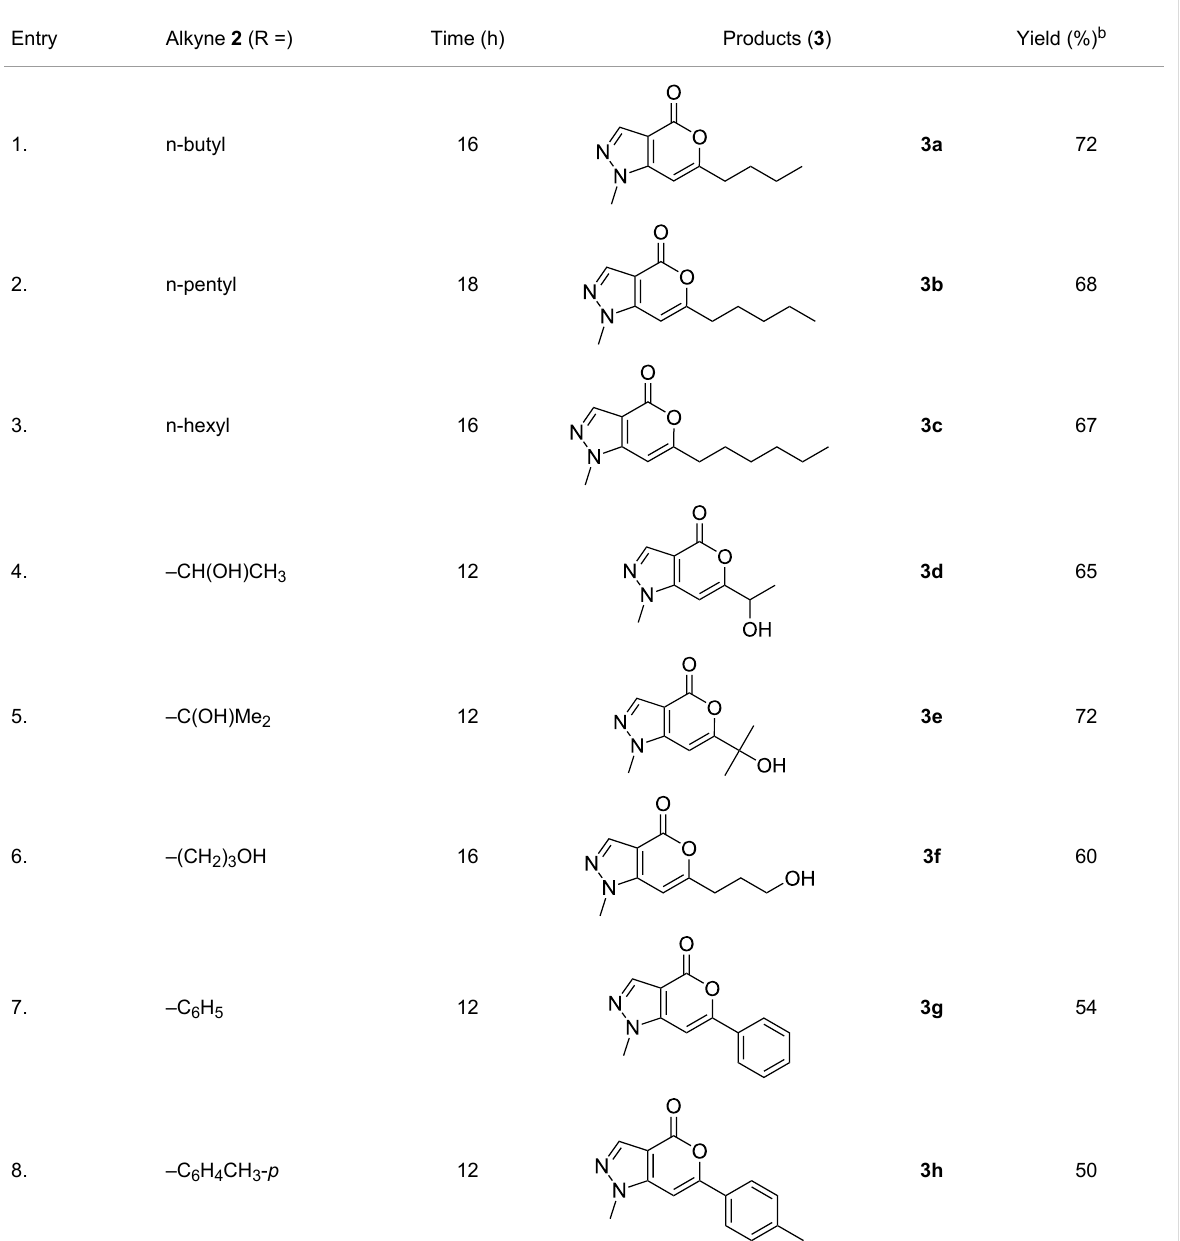
Table 2: Pd/C-mediated synthesis of 6-substituted pyrano[4,3- c ]pyrazol-4(1 H )-ones a ( 3 ).